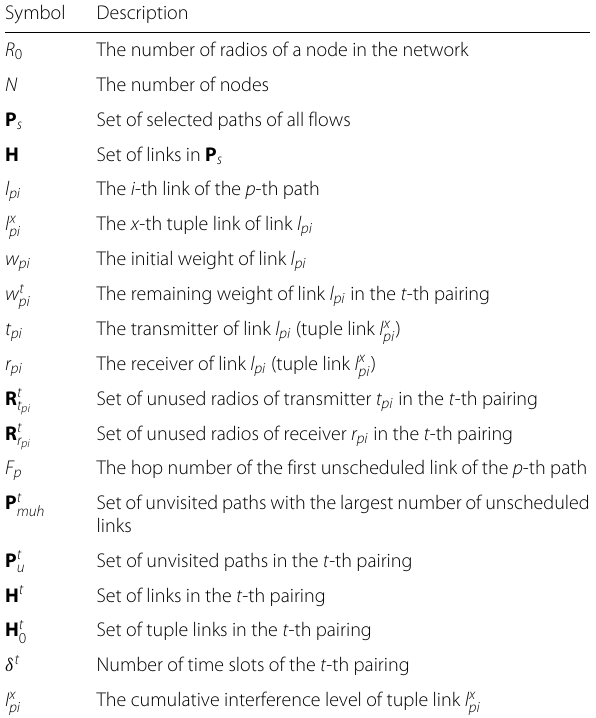
Table 2 Notation in